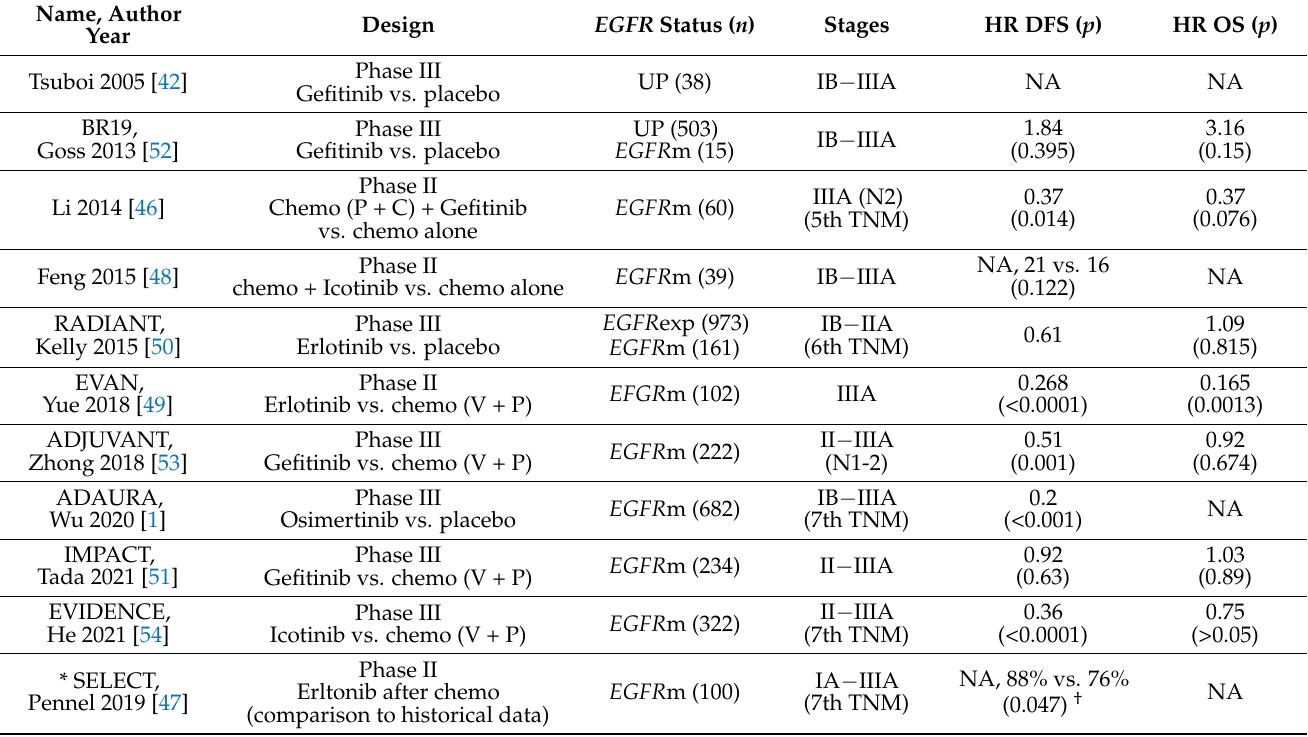
Table 3. Results of the main trials considering adjuvant